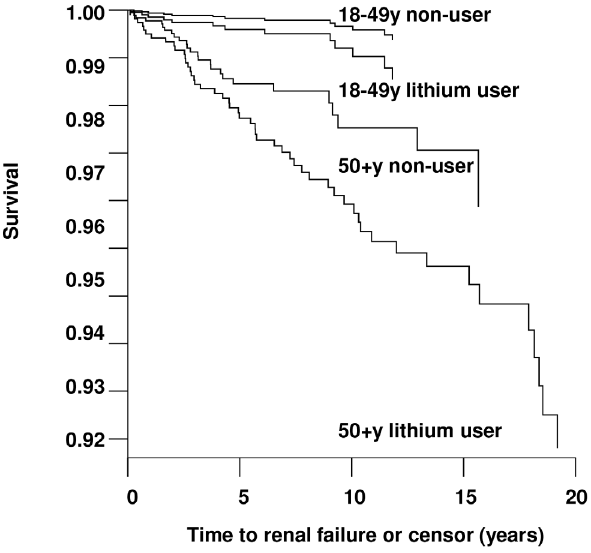
Figure 2. Renal failure survival curves for younger and older lithium and non-lithium